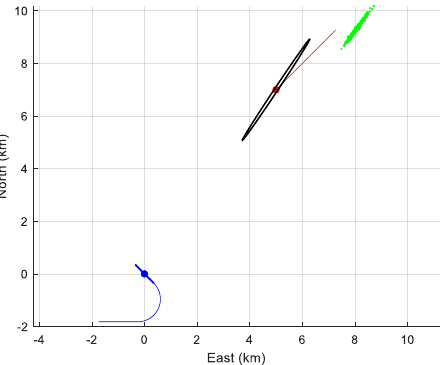
Figure 8. The cloud (in green) of the 500 initial positions estimates given by the classic BOTMA together with the 90%−confidence ellipse.